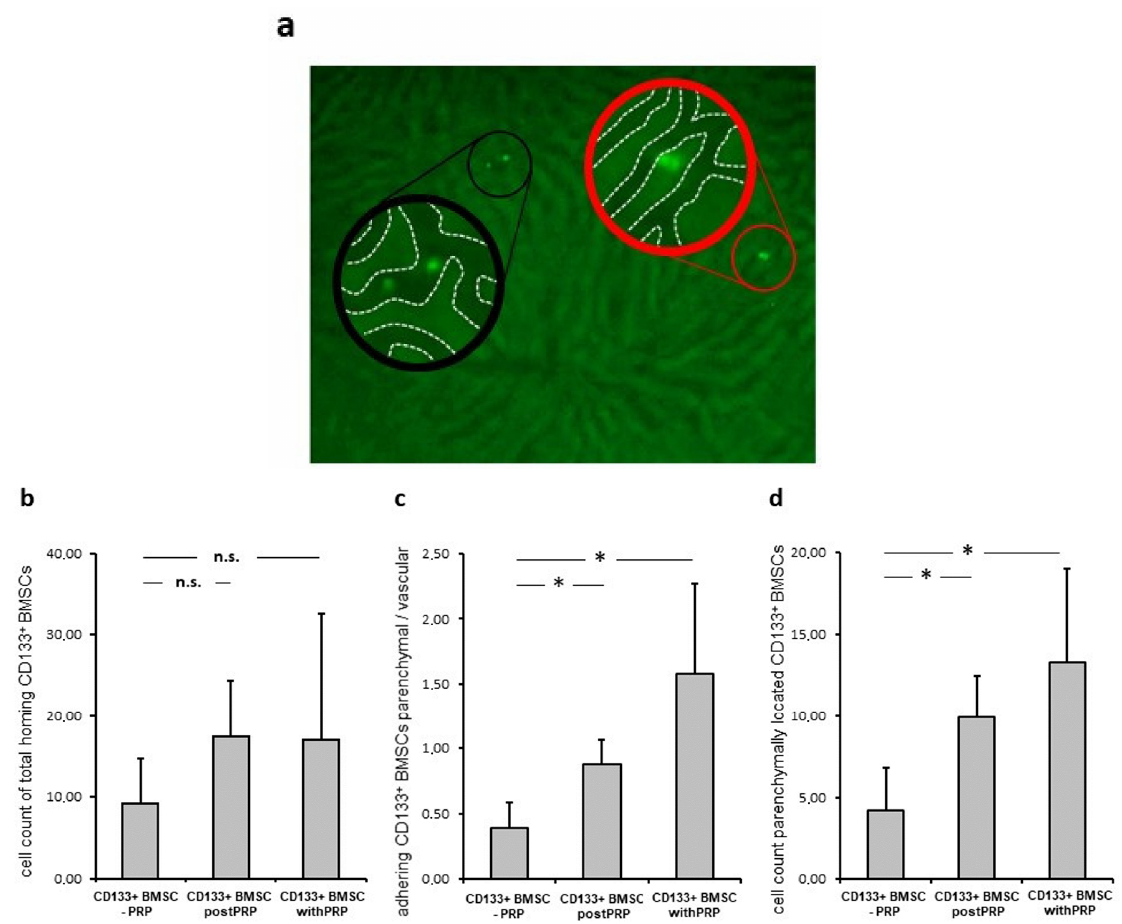
Figure 4. Platelets increase CD133 + BMSC binding and extravasation in an ischemia and reperfusion injury model. CD133 + BMSC were infused to the rat liver after 180 min of reperfusion. In Situ Imaging by fluorescence microscopy of 10 different visual fields. ( a ) In situ Imaging: Extra-sinusoidal (parenchymatous, red circle) vs. sinusoidal (intra-vascular, black circle) CD133 + BMSC after liver passage. Membranes of CD133 + BMSC were labeled prior to in situ perfusion with PKH67 Green to analyze amount and localization of human BMSC homing to the rat liver by fluorescence microscopy of at least 10 different visual fields. ( b ) IPRL: Increase of absolute numbers of CD133 + BMSC homing to the liver (CD133 + BMSC cell count per 10 visual fields) without platelet co-treatment (column 1; -PRP) versus CD133 + BMSC pre-infusion of PRP and subsequent infusion of stem cells to the rat liver (column 2; postPRP) versus CD133 + BMSC co-incubated with PRP and subsequent co-infusion (column 3; withPRP). ( c ) Relation of parenchymal versus vascular located CD133 + BMSC in these 3 groups. ( d ) Absolute numbers of CD133 + BMSC located to the extra-sinusoidal parenchyma. * p < 0.05; n.s., not significant.